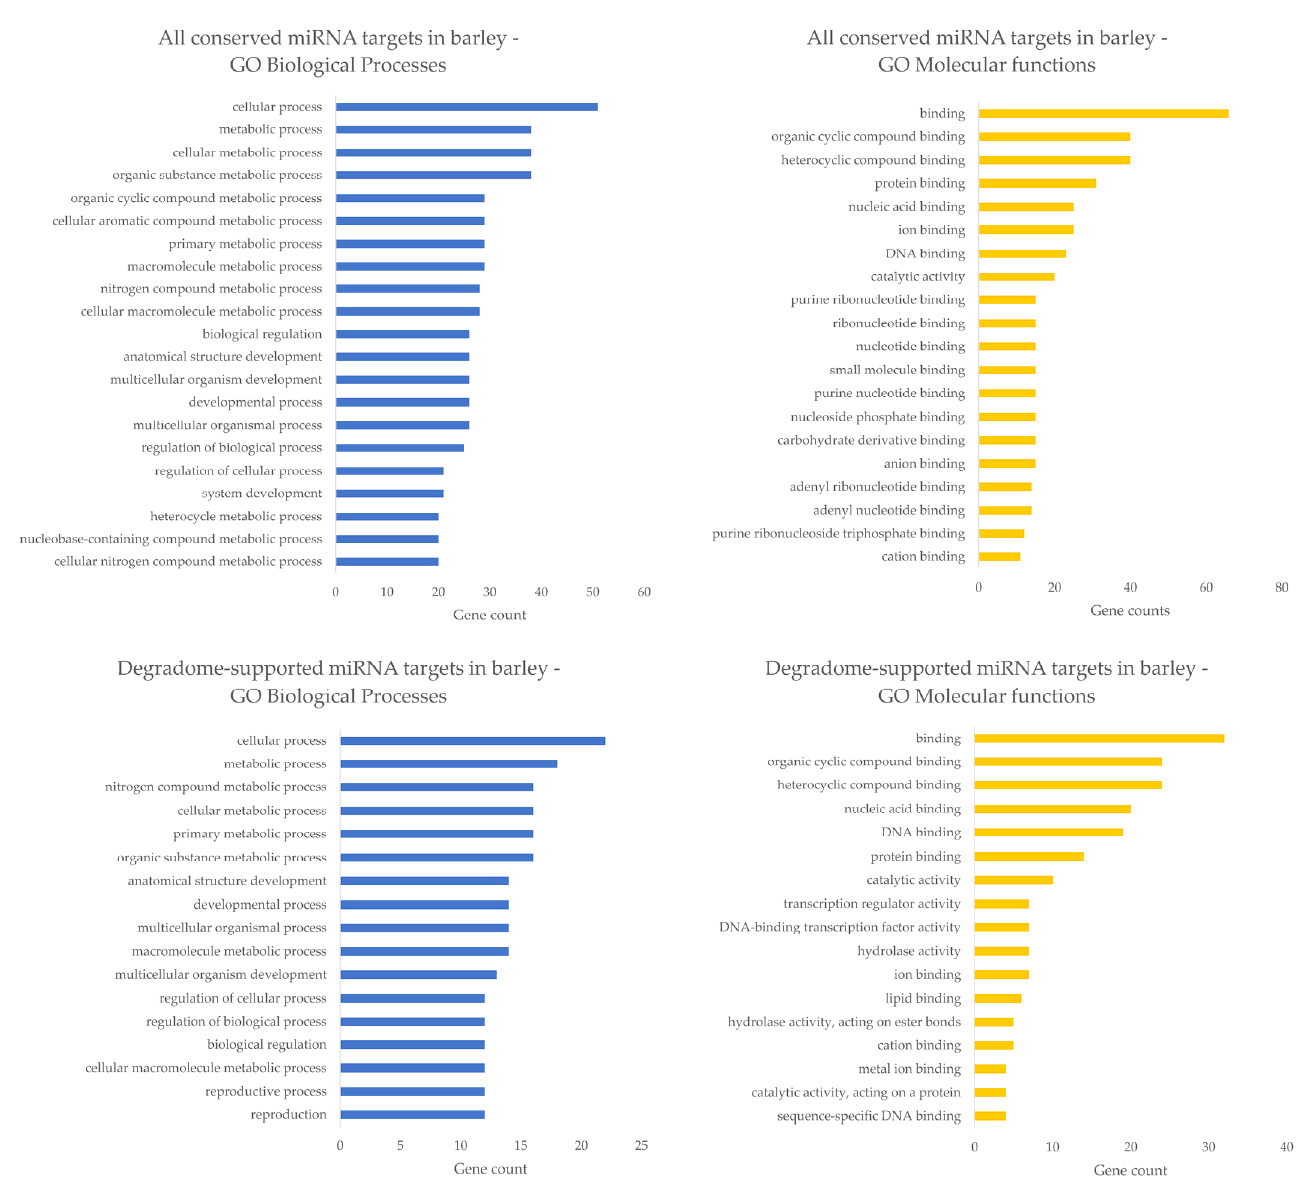
Figure 4. Biological processes and Molecular functions of miRNA targets in barley. In the upper half of the image, the most abundant GOs of all conserved miRNA targets in barley are shown. In the lower half of the image, the most abundant GOs of degradome-supported miRNA targets are depicted. Blue bar plots stand for biological processes, whereas the orange ones correspond to molecular functions.